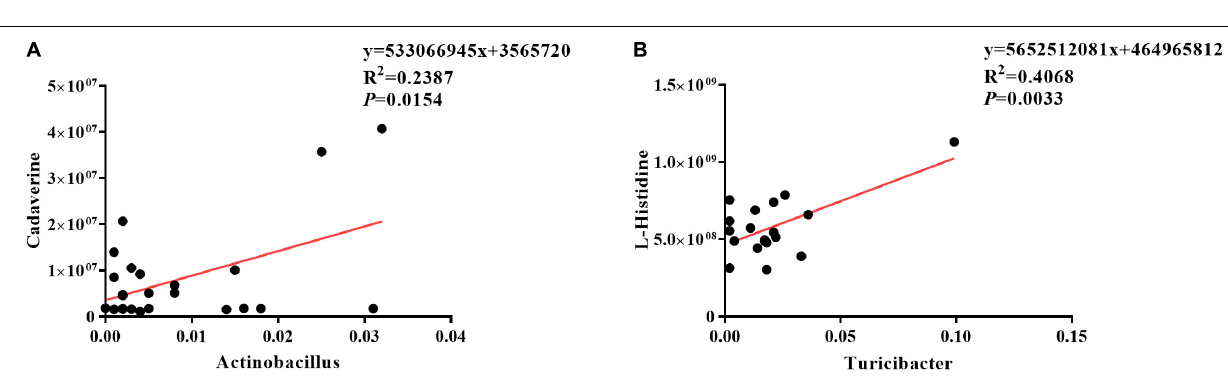
FIGURE 8 | Correlation analyses between ileal mucosa microbiota and metabolites. (A) Cadaverine vs. Actinobacillus , (B) L-histidine vs. Turicibacter